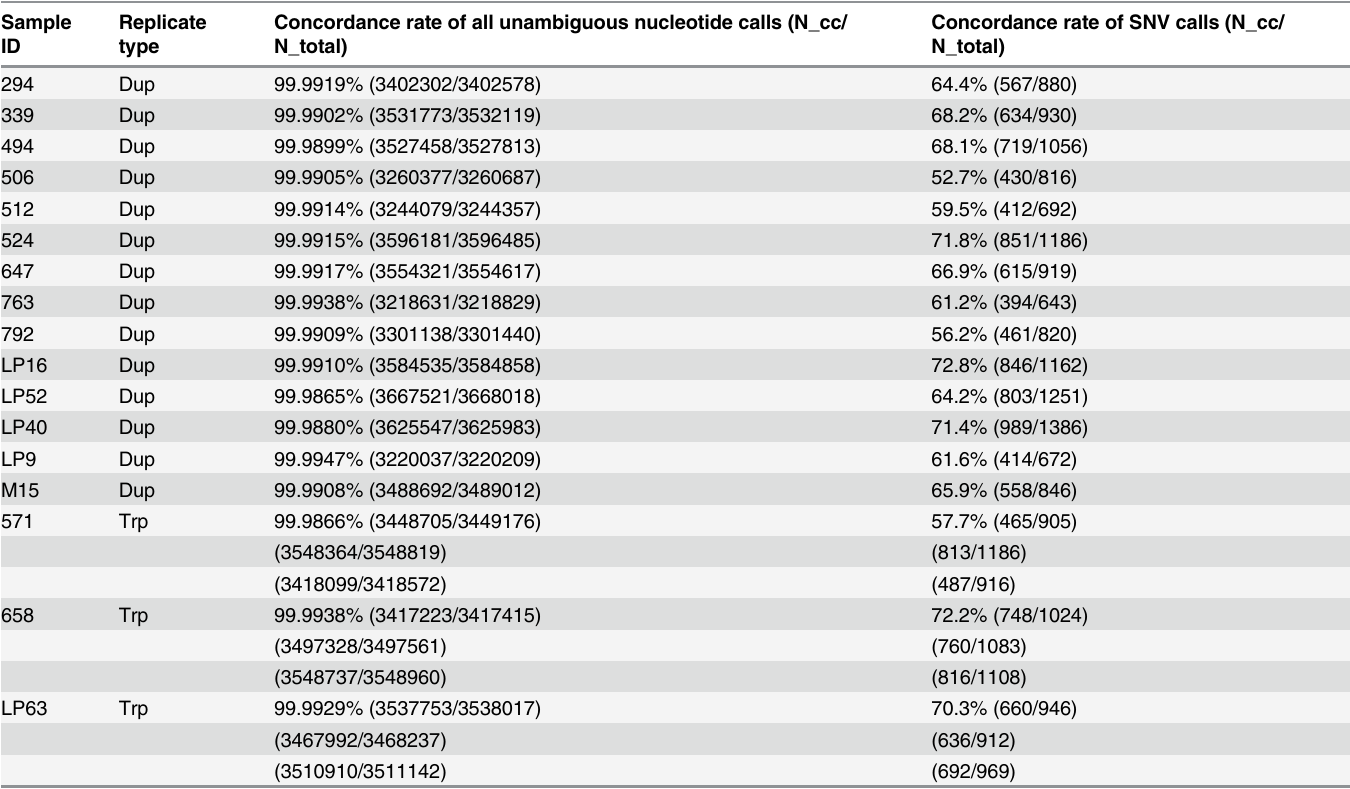
Table 2. Concordance rates between pairs of replicated samples of all unambiguous nucleotide calls over the entire sequenced regions and of SNV calls. Sample